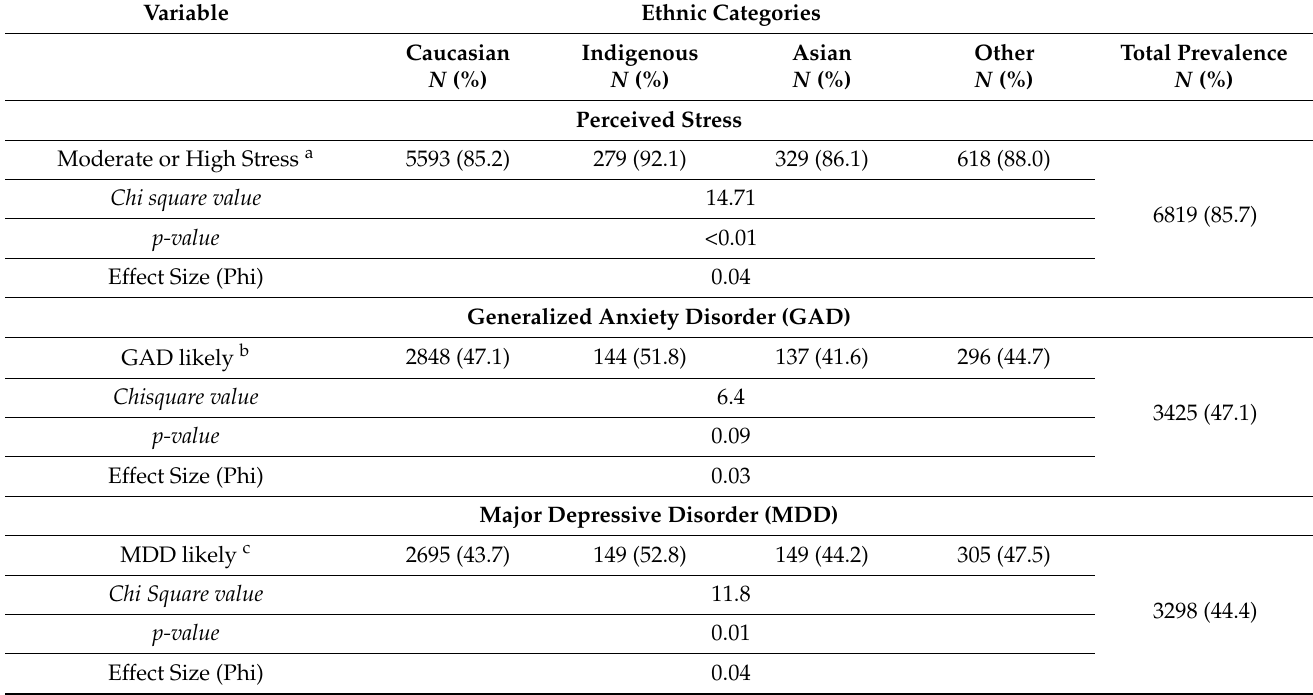
Table 2. Association between ethnic categories and prevalence of perceived stress, likely GAD, and likely MDD.